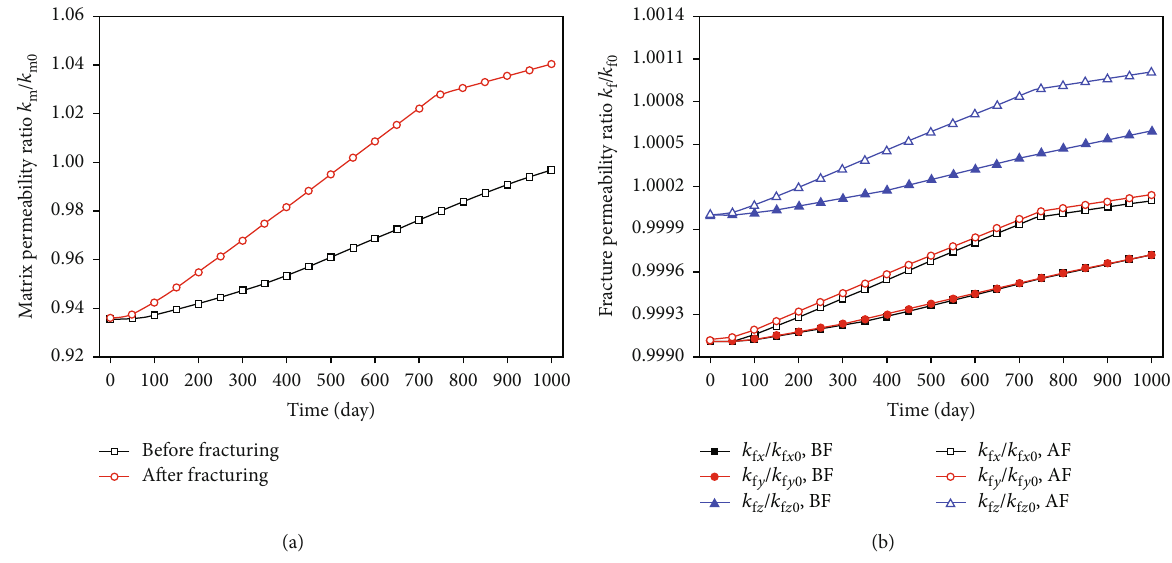
Figure 18: Matrix permeability ratio and fracture permeability ratio before fracturing and after fracturing: (a) matrix permeability ratio and (b) fracture permeability